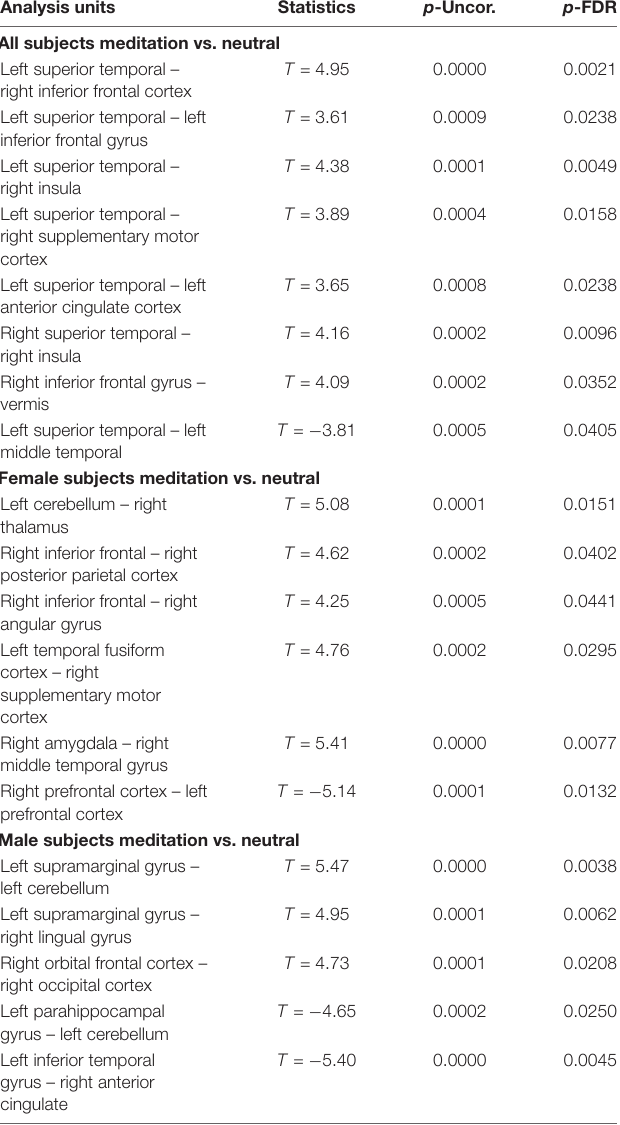
TABLE 2 | Comparison between the neutral and OM conditions for all subjects, the males separately, and females separately, showing the significant differences in functional connectivity between selected structures and the uncorrected p value (p-Uncor.) and False Discovery Rate corrected p -value